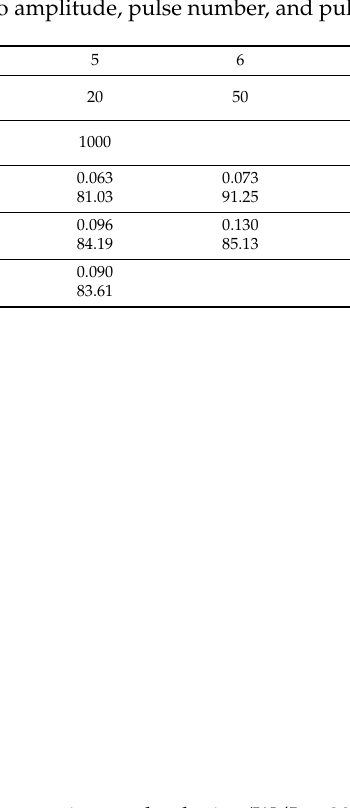
Figure 3. Range of fluctuation in the threshold voltage turning on the device (W/L = 200/100 µ m). D30 (filled color) displays the ~30-nm CeO x with HfAlO x device and D70 (empty color) displays the ~70-nm with HfAlO x